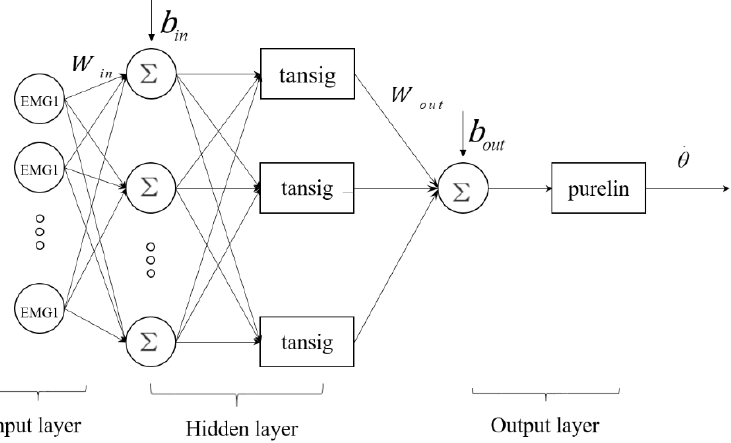
Figure 7. Structure of the BP neural network.